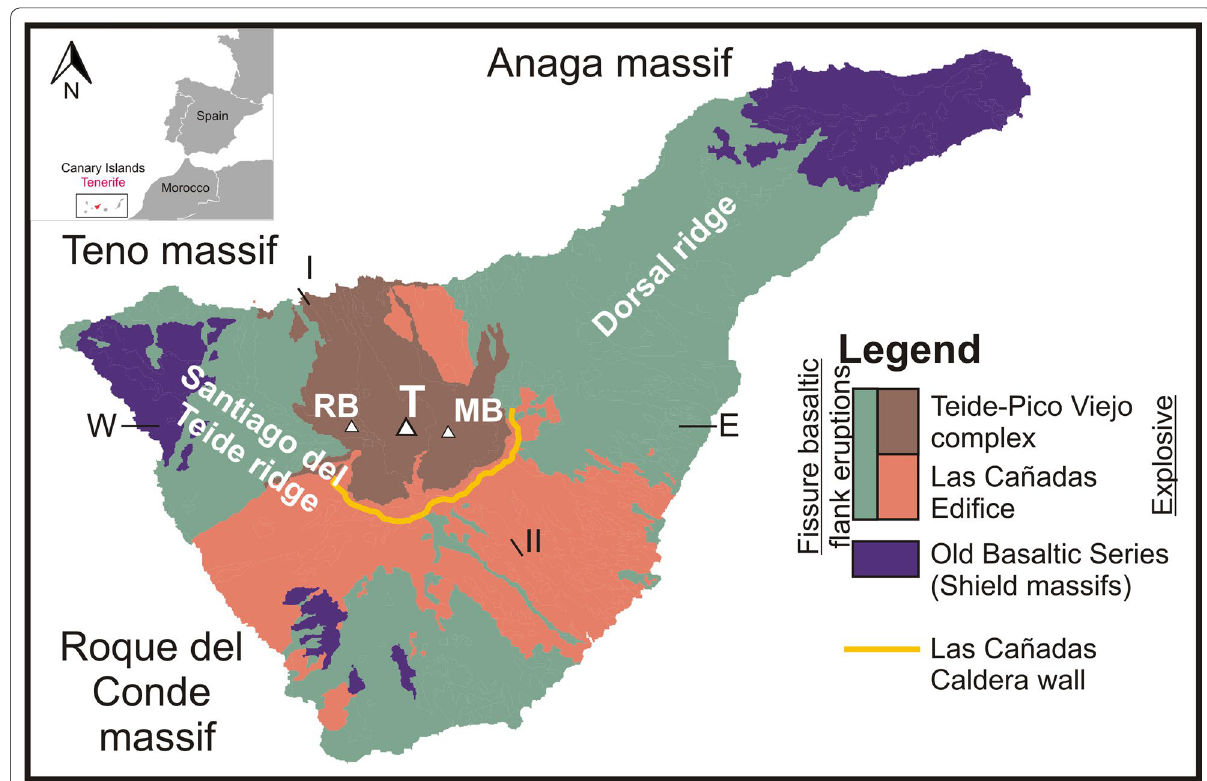
Fig. 1 Simplified geological map of Tenerife Island. T Teide; MB Montaña Blanca; RB Roques Blancos; I–II: section shown in Fig. 5; E–W: section shown in Fig. 2. (Modified from Piña‑Varas et al.